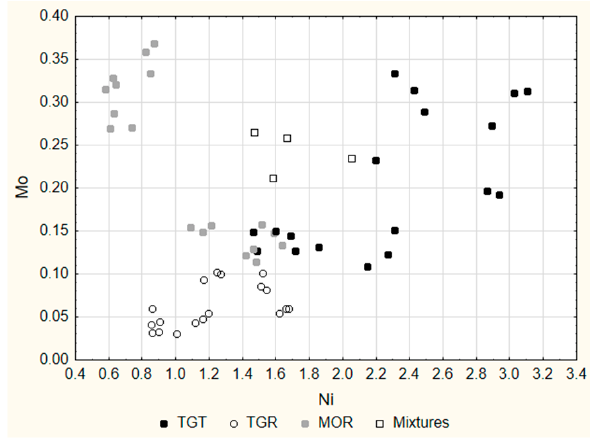
Figure 4. Two-dimensional plot of the 54 samples: Mo vs. Ni.